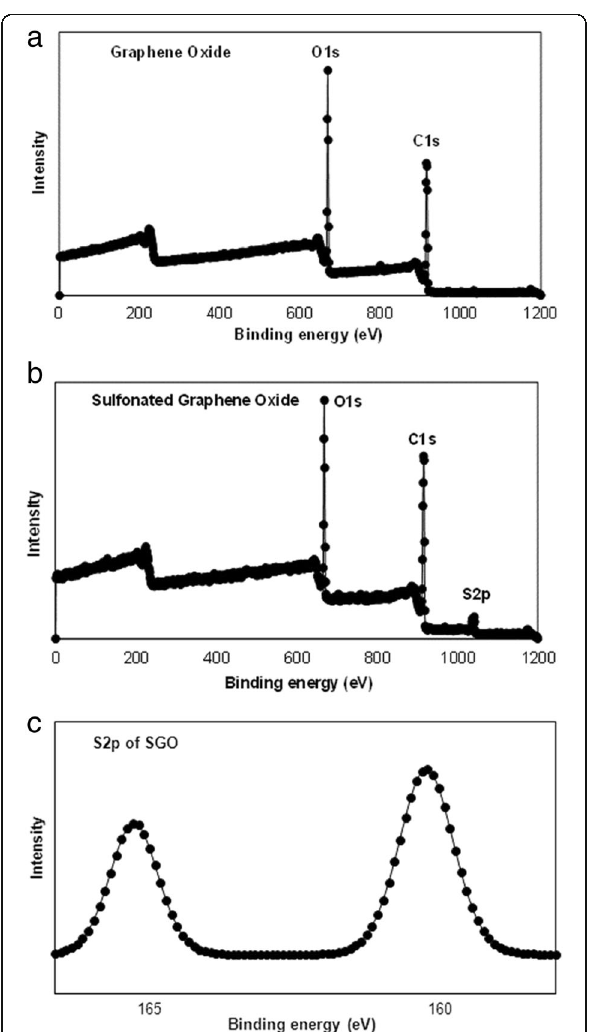
Fig. 2 XPS of a , b wide spectra GO and SGO and c S2p spectra of